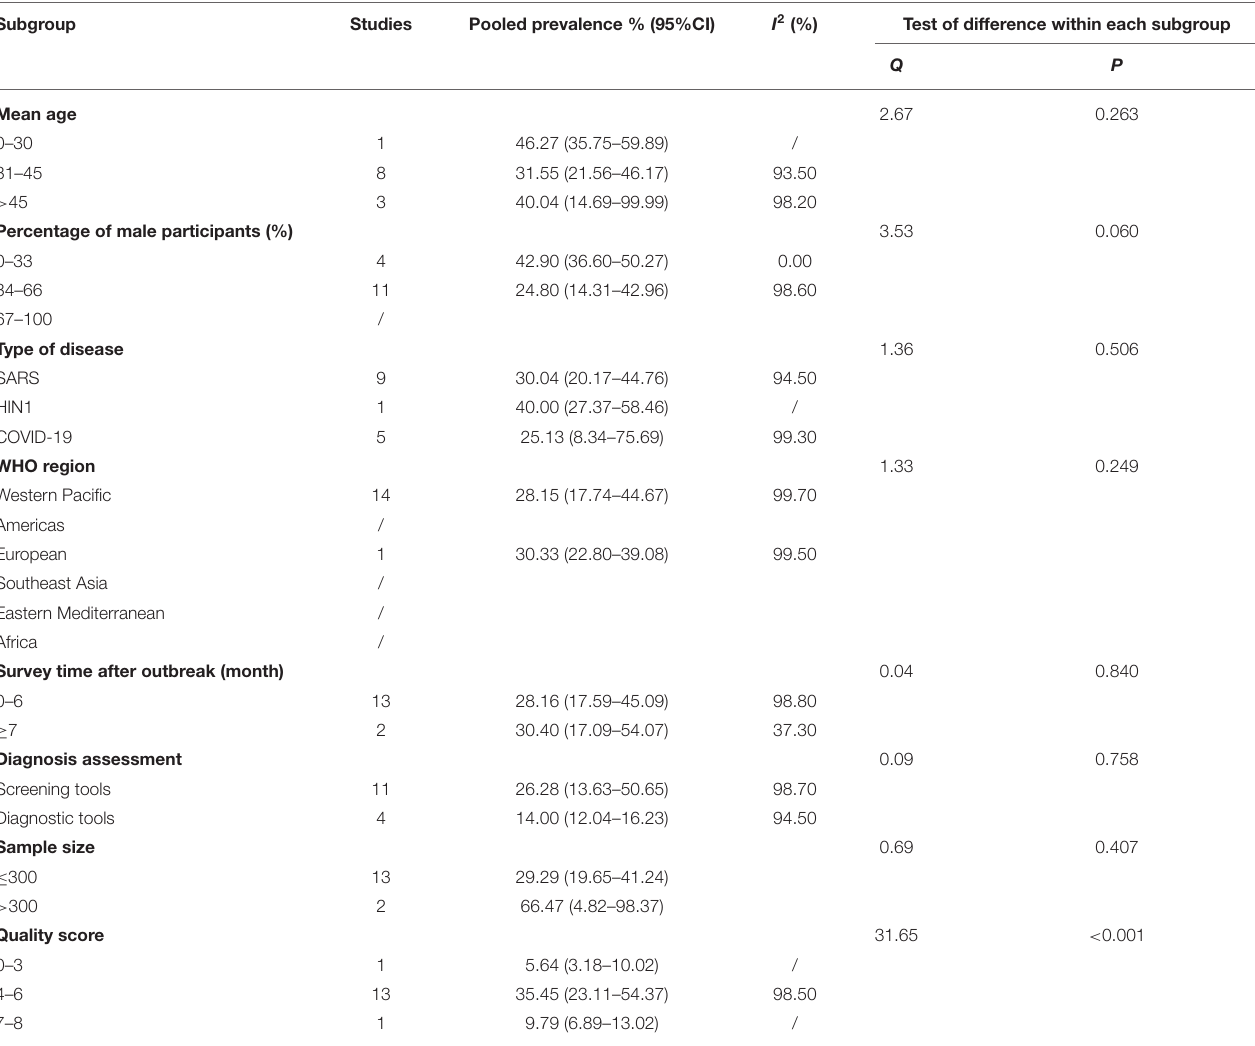
TABLE 4 | Subgroup analysis for patients with infectious disease.